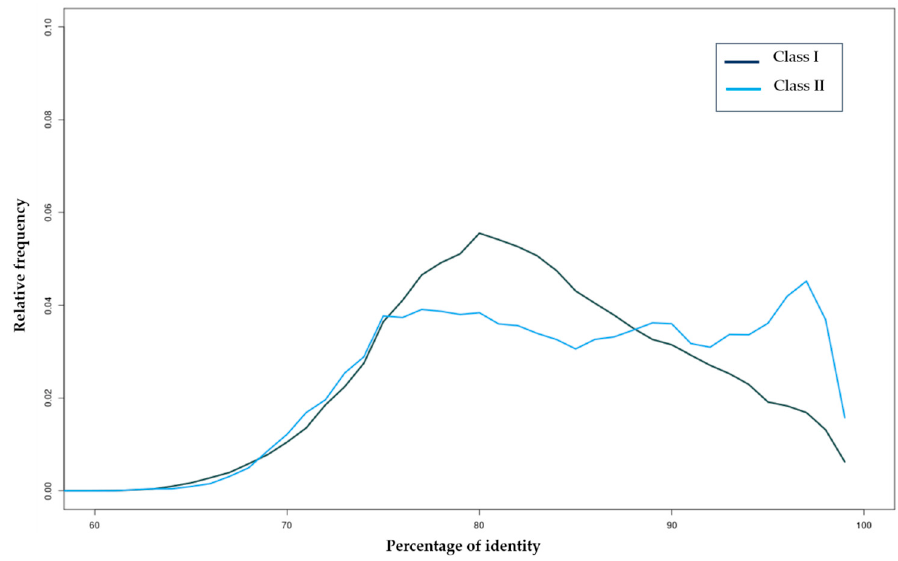
Figure 2. Distribution of sequence identity values between TE copies and TE sequences with at least one full-length copy for Class I and Class II elements. The relative frequencies per percentage of identity of Class I and Class II are represented in different colors.